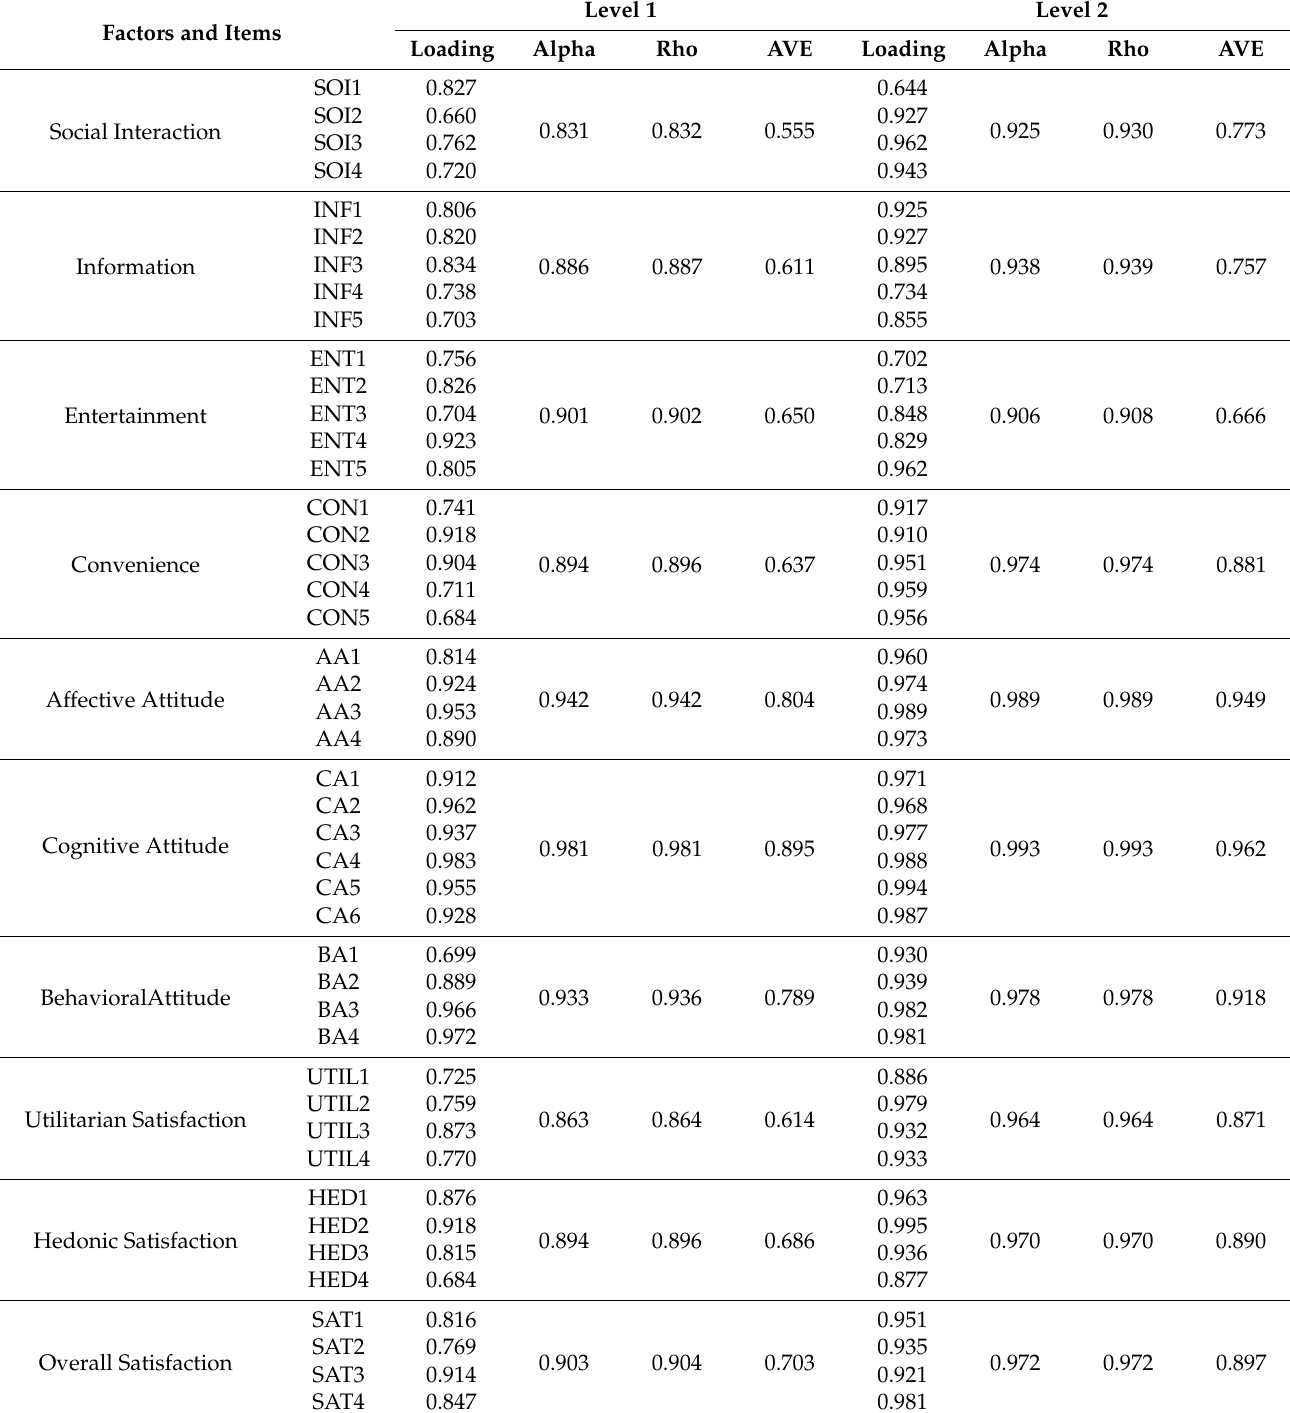
Table 2. Factor Loadings, Reliability Coefficients, and AVEs of Modified Multilevel